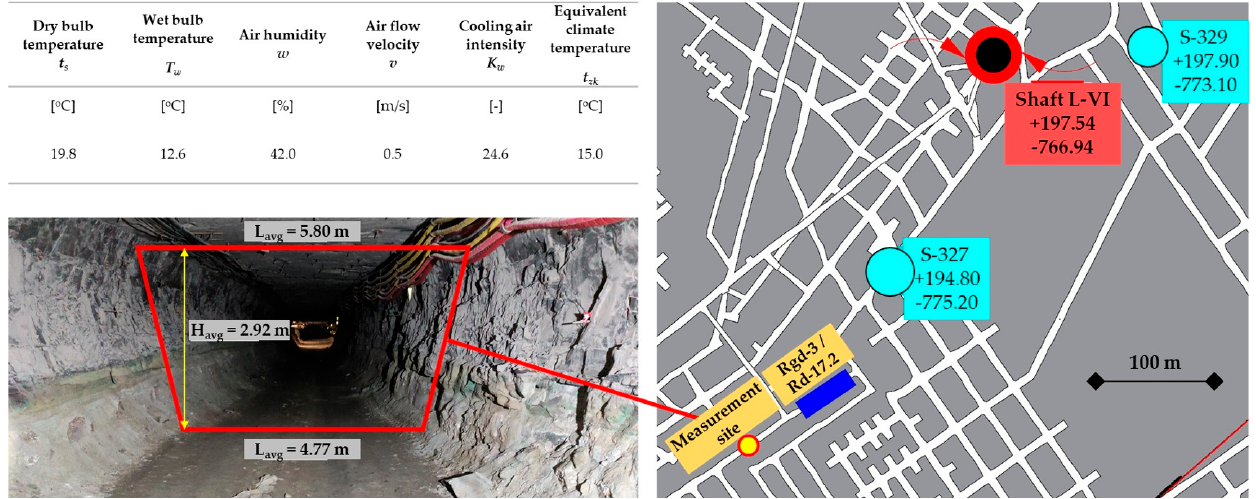
Figure 3. Geometry of underground excavation and air flow parameters in the area of the measuring site ( left ) and location of the ventilation shaft and exploration drills next to the area of the radiation measurement ( right ).